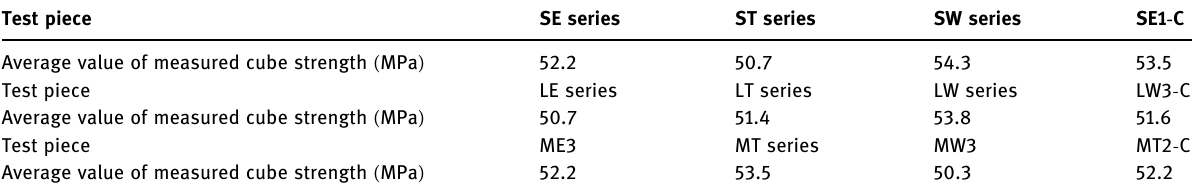
Table 6: Compressive strength of concrete ( f cu )